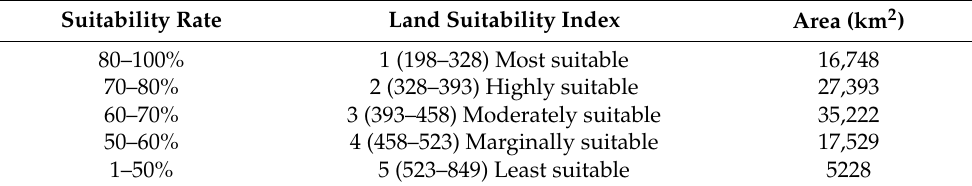
Table 11. Land suitability